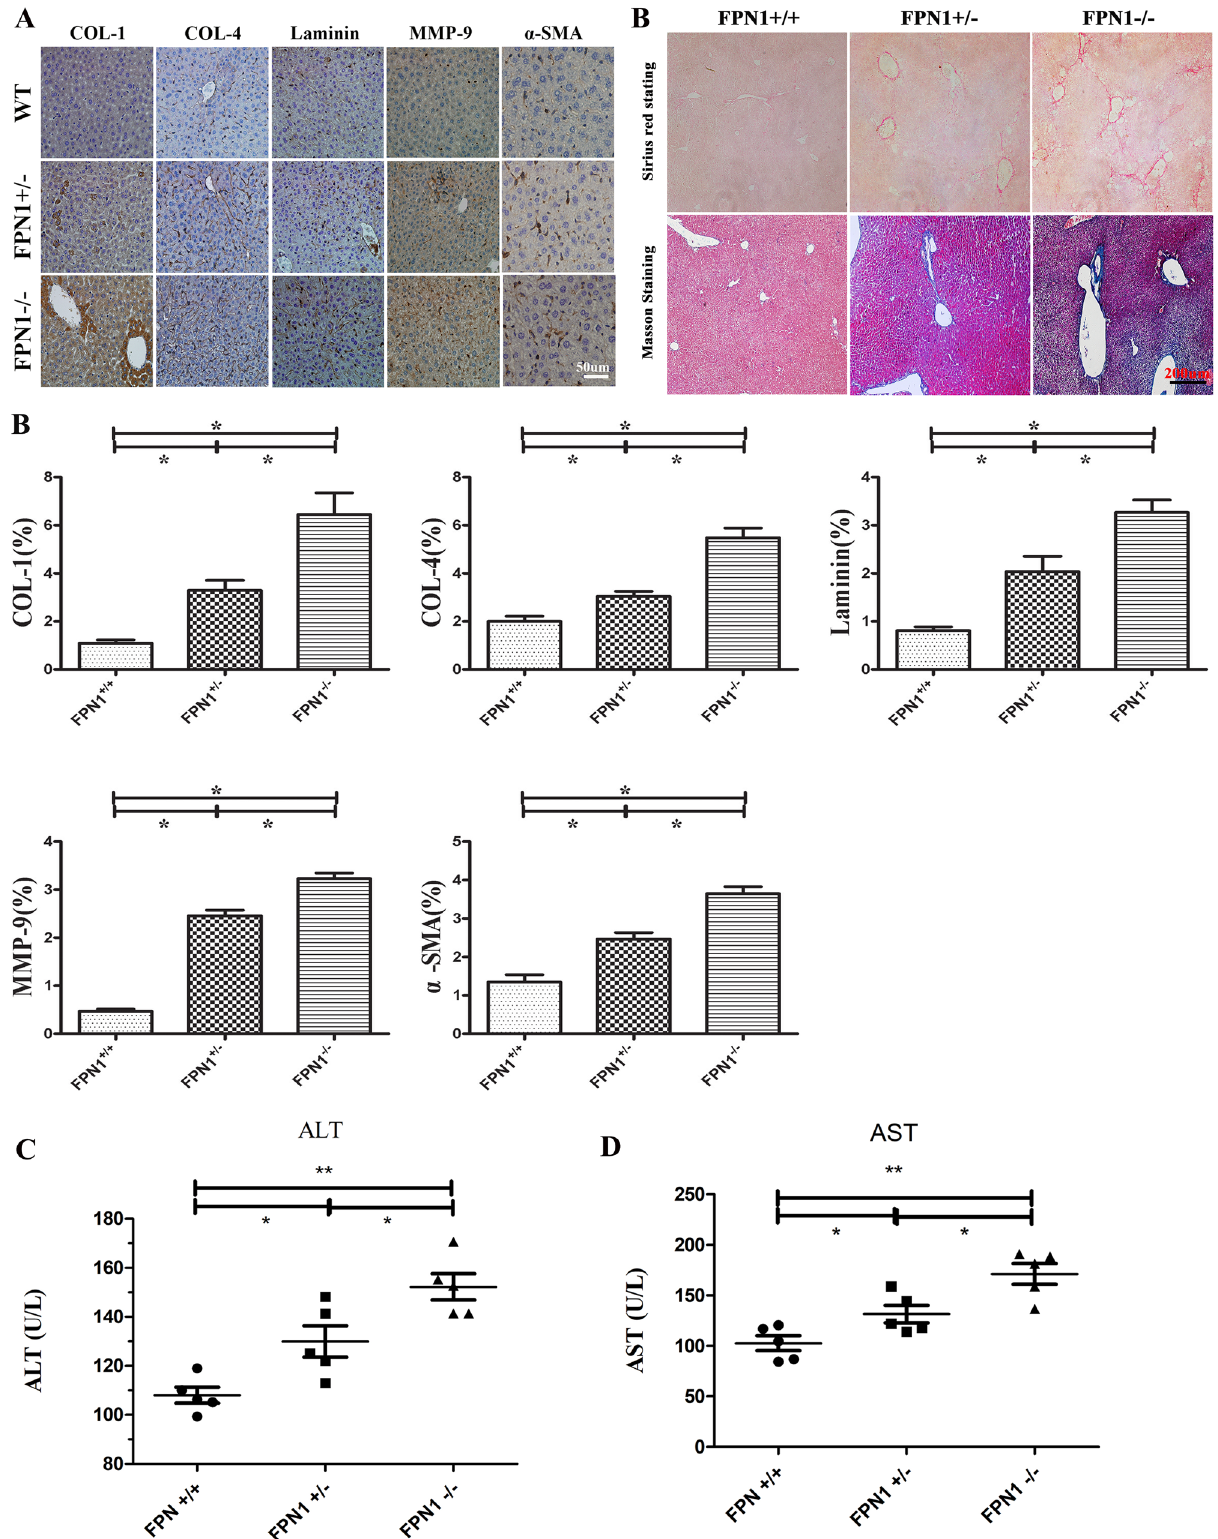
Figure 3. Downregulation of FPN1 in hepatic cells induced liver fibrosis. ( A ) Liver sections were incubated with antibodies against COL-1, COL-4, Laminin, α-SMA, and MMP-9 and stained with Sirius red or Masson (× 400). ( B ) Error bars correspond to the mean ± standard deviation of IHC. ALT ( C ) and AST ( D ) content in mouse serum ( FPN1 +/+ , FPN1 −/+ , FPN1 −/− ). All results are from three independent experiments. * P < 0.05, ** P <